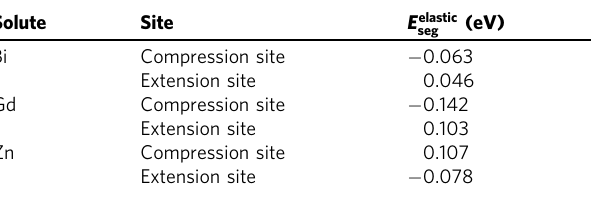
Table 2 Elastic strain contributions to segregation